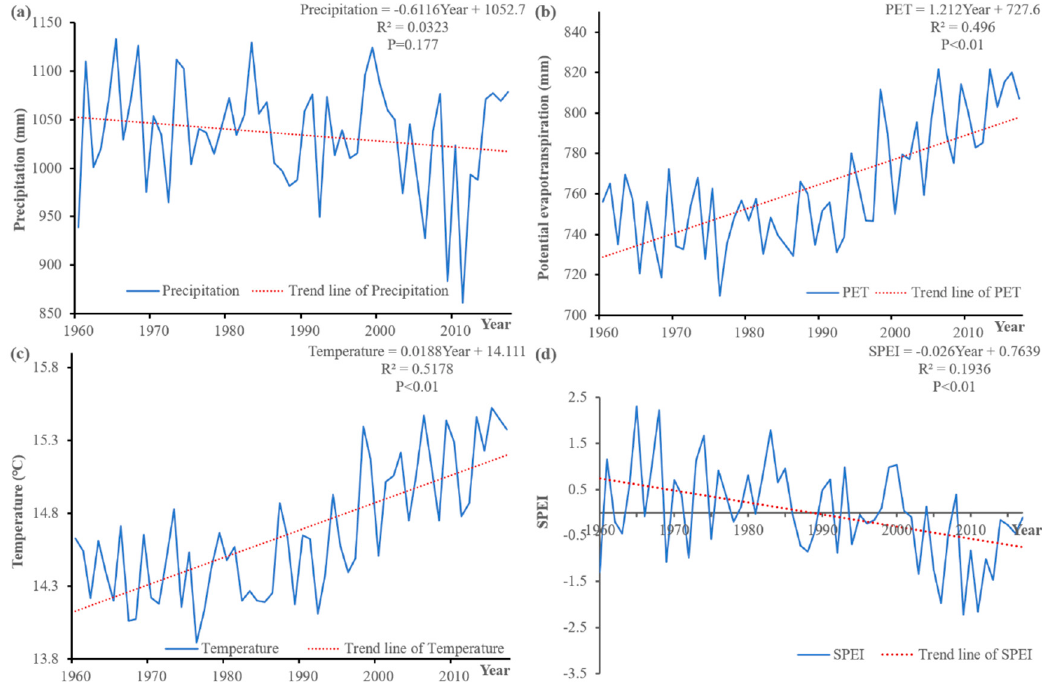
Figure 2. Changing trend of annual ( a ) precipitation, ( b ) potential evapotranspiration (PET), ( c ) temperature, and ( d ) SPEI in the period from 1960 to 2017.